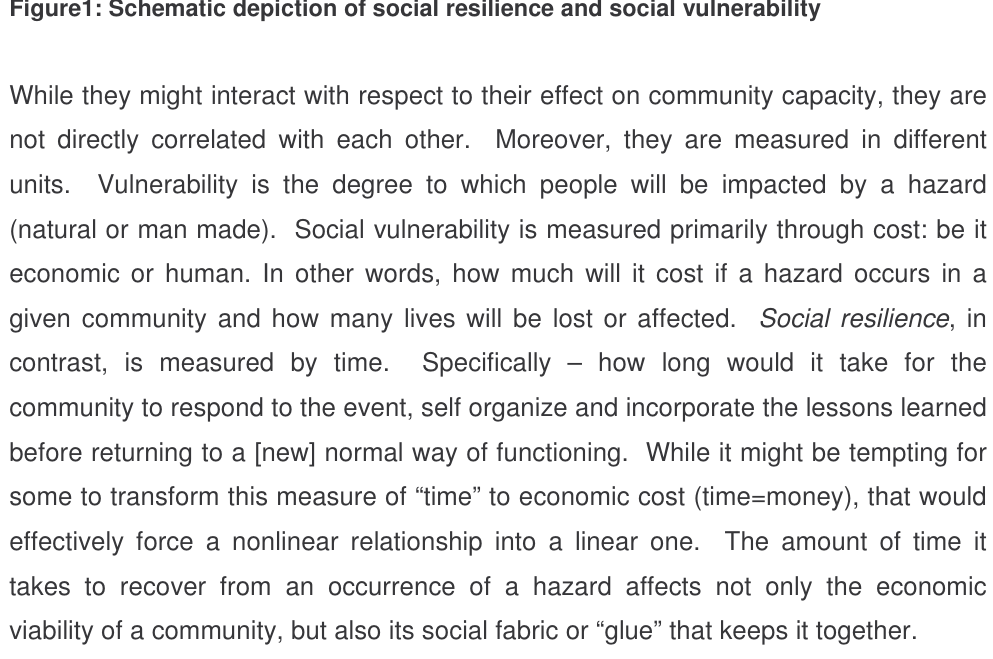
Figure1: Schematic depiction of social resilience and social vulnerability